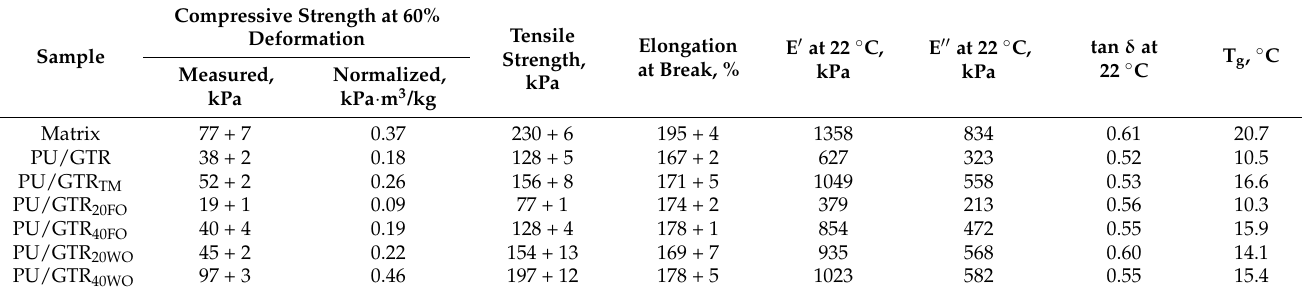
Table 3. The results of static and dynamic mechanical analysis of prepared polyurethane foams.